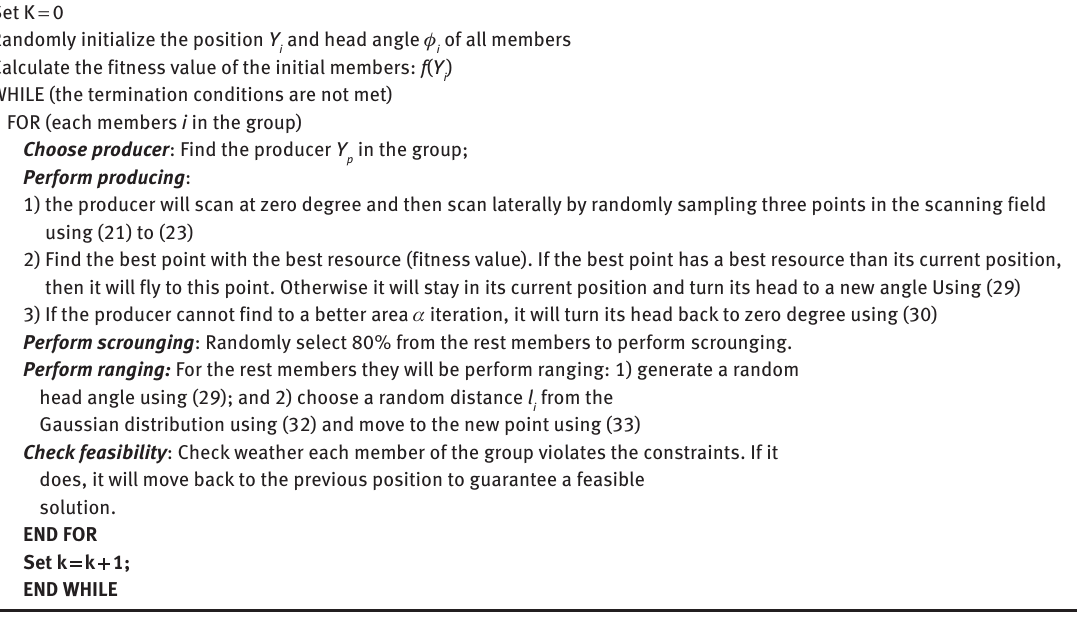
Table 4: Overall Process of GSO